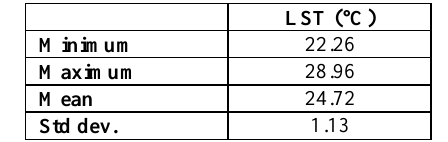
Table 3. Statistics of the Land Surface Temperature image